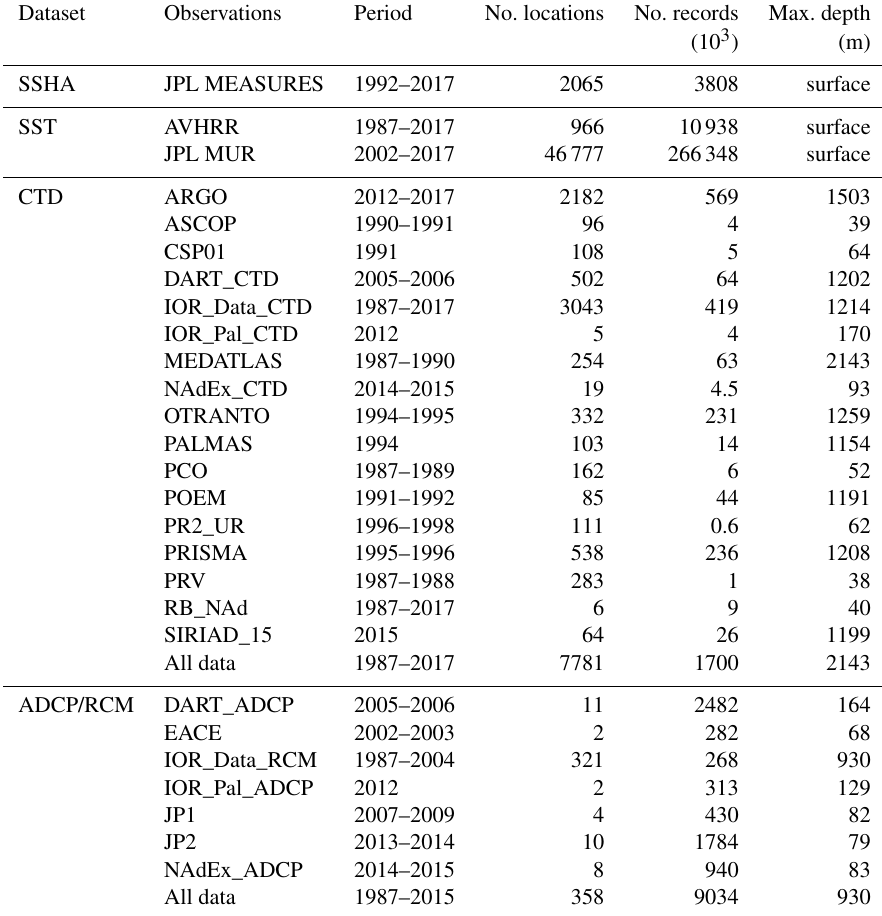
Table 2. Name and period of the observations, number (no.) of locations and records, and maximum measured depth for the four datasets – i.e. (1) sea surface height anomalies (SSHAs), (2) sea surface temperatures (SSTs), (3) conductivity–temperature–depth (CTD) observations, and (4) acoustic Doppler current profiler (ADCP) or rotor current meter (RCM) measurements – used to evaluate the AdriSC ROMS 3km and 1km models over the 1987–2017